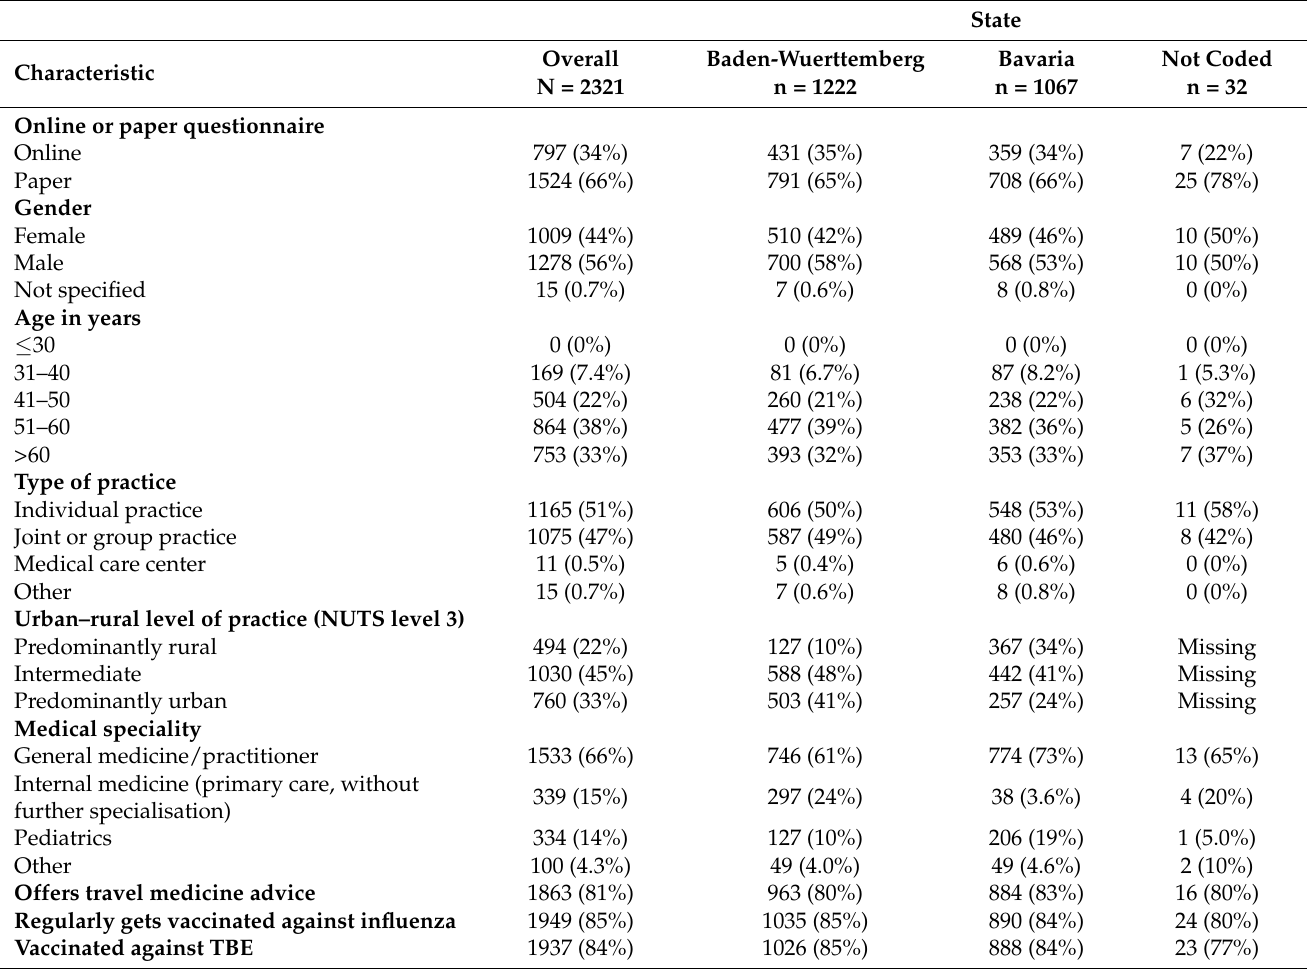
Table 1. Characteristics of primary care physicians participating in the TBD-Prev survey, Baden- Wuerttemberg and Bavaria, Germany, 24 May–30 September